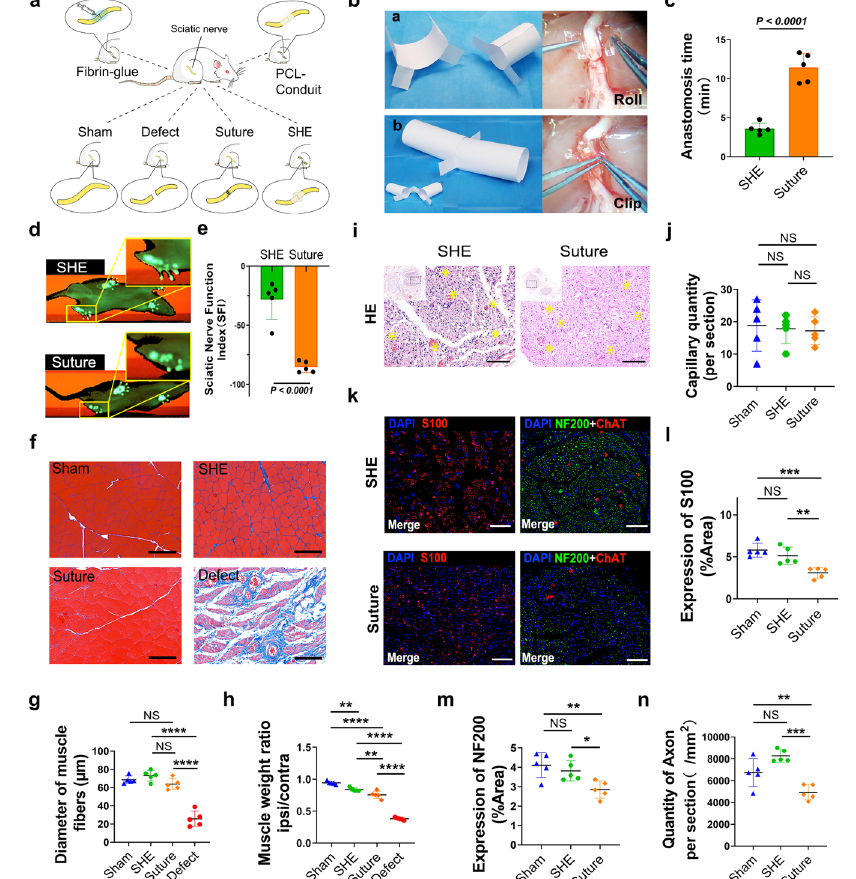
Fig. 4 was missing from the PDF version of this article; the fi gure should have appeared as shown below. The original article PDF has been corrected. The HTML version was